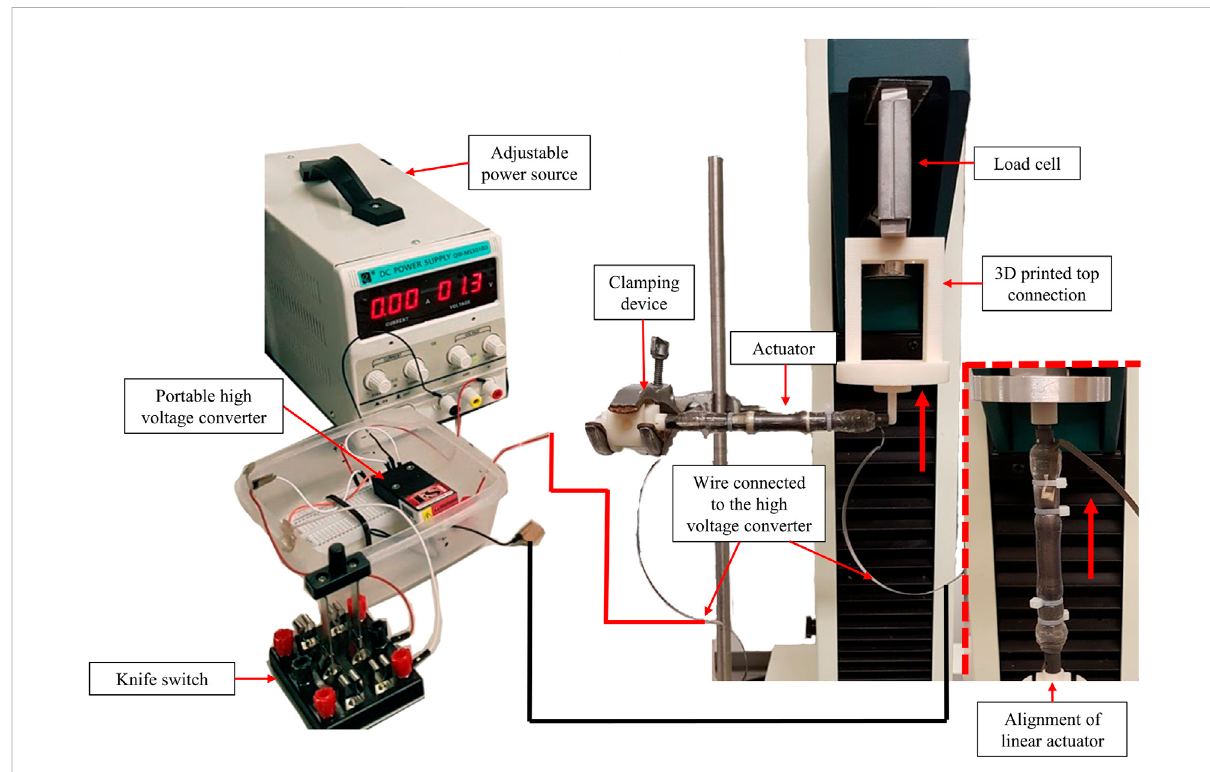
FIGURE 10 Force output test setup for bending-type spring-roll DE actuator (the alignment of the linear-type actuator as shown in the right